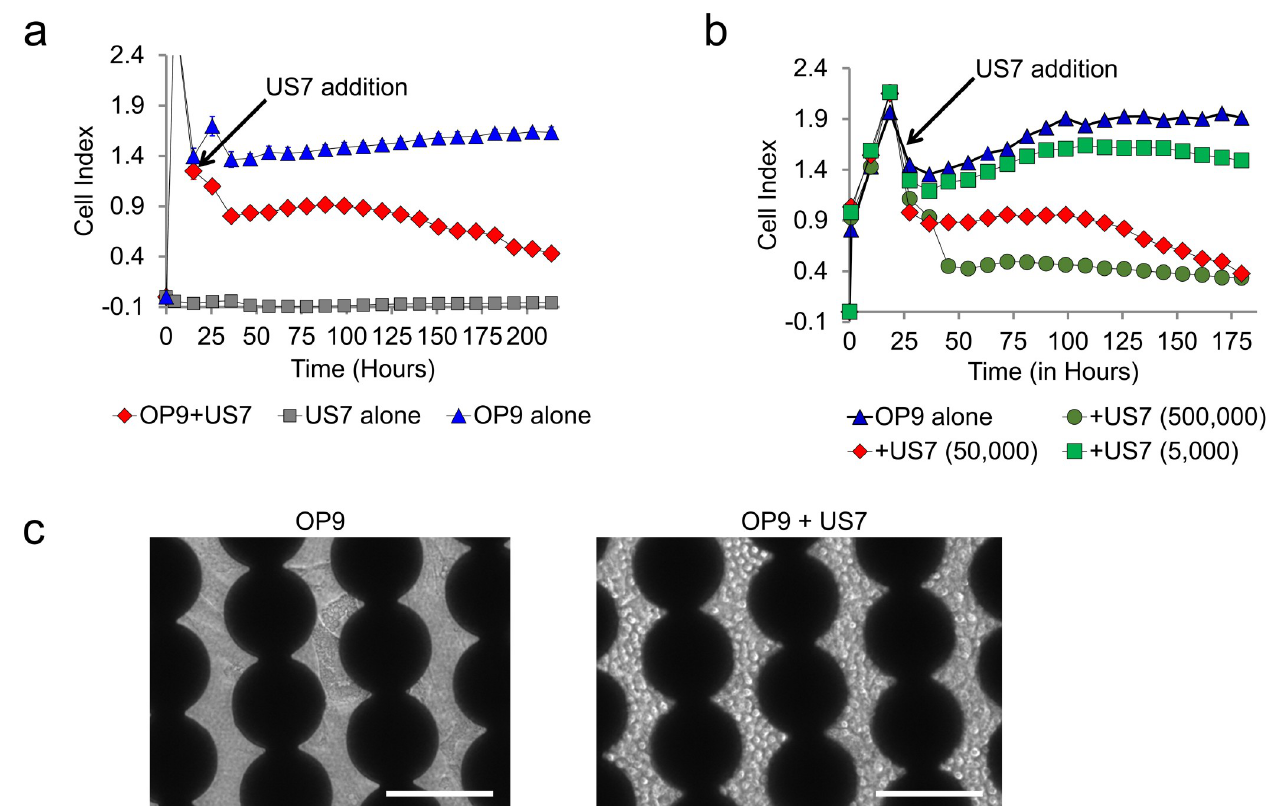
Fig 2. Impedance measurement of OP9 stromal cell adhesion and displacement by BCP-ALL cells. (A) Impedance was measured over 7 days in wells containing OP9 alone (10,000 cells/well), US7 alone (50,000 cells/well) and US7 plated on OP9 feeder cells as indicated (n = 2). When added to the well, OP9 stromal cells adhere to the electrodes and increase impedance (Cell Index) over time. PDX-derived BCP-ALL cells (US7) do not attach to the electrodes and do not affect the measured impedance; however, when co-cultured with OP9, they cause a reduction in impedance. (B) Impedance in co-culture of OP9 cells with different amounts of US7 cells as indicated below the figure (n = 2, triangle = no cells, diamond = 50,000 cells, square = 5,000 cells, circle = 500,000 cells). The reduction in impedance is proportional to the number of added US7 cells. (C) Bright field images of OP9 alone (10,000 cells/well) or OP9 and US7 BCP-ALL cells (50,000 cells/well) 7 days after leukemia cell addition. Dark areas are generated by electrodes blocking the light path in the inverted microscope. Cells are visible in the clear space between electrodes. Scale bar = 100 μ m.